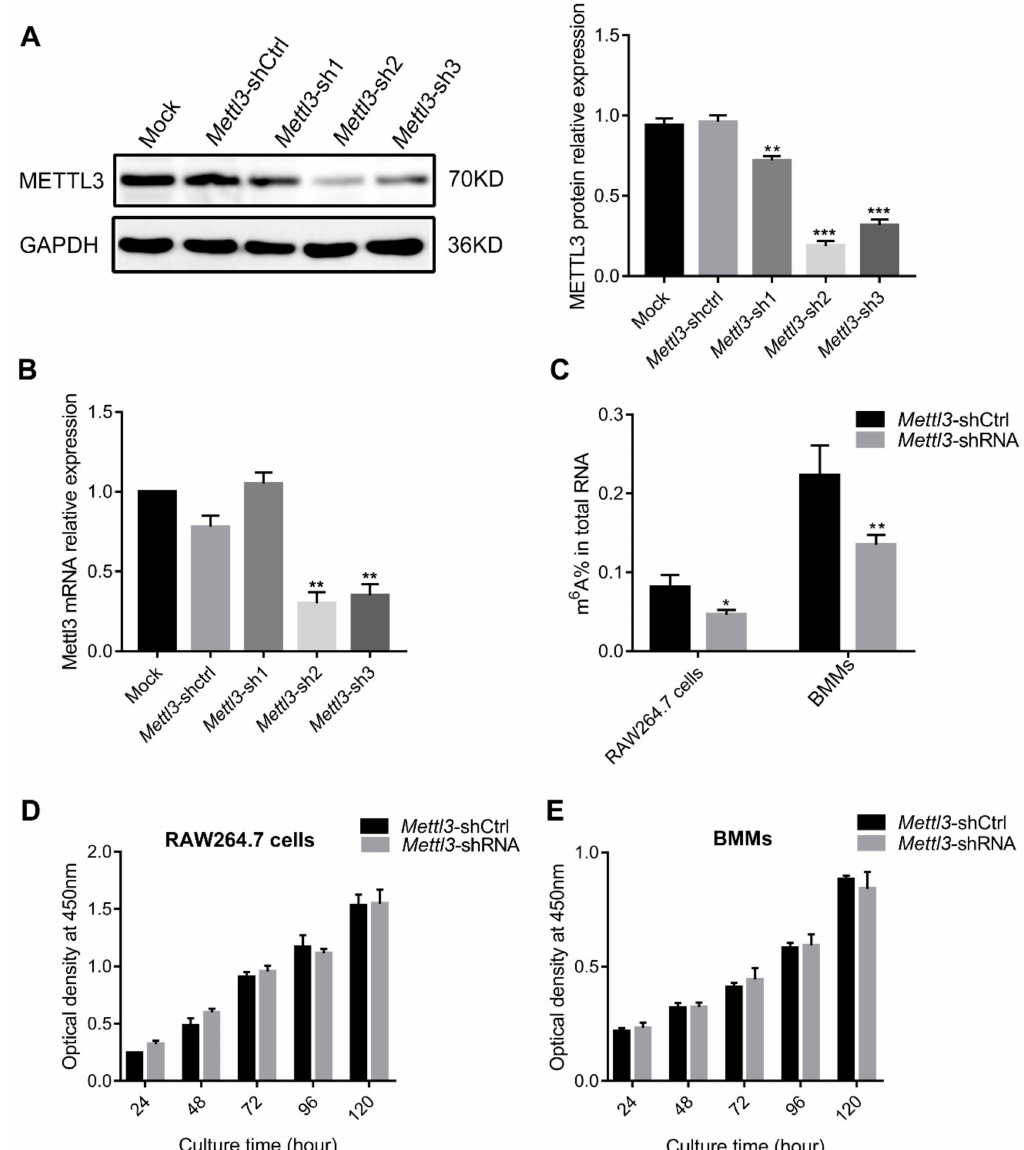
Figure 2. E ff ect of Mettl3 knockdown on the m 6 A methylation levels and proliferation of osteoclast precursor cells. The e ffi ciency of Mettl3 knockdown was determined by both Western blotting ( A ) and qRT-PCR ( B ). Mock, cells transfected with transfection reagent; Mettl3 -shCtrl, cells transfected with negative control shRNA; Mettl3 -shRNA, cells transfected with Mettl3 shRNA. GAPDH was used as an internal control. ( C ) The total m 6 A content in RAW264.7 cells and BMMs was measured by quantifying m 6 A RNA methylation. Cell growth of RAW264.7 cells ( D ) and BMMs ( E ) in Mettl3 -shRNA and Mettl3 -shCtrl groups was detected using a CCK8 assay after culturing for di ff erent times. The results are presented as the mean ± SD (n = 3). Significant di ff erences relative to the Mettl3 -shCtrl group. * P < 0.05; ** P < 0.01; *** P <